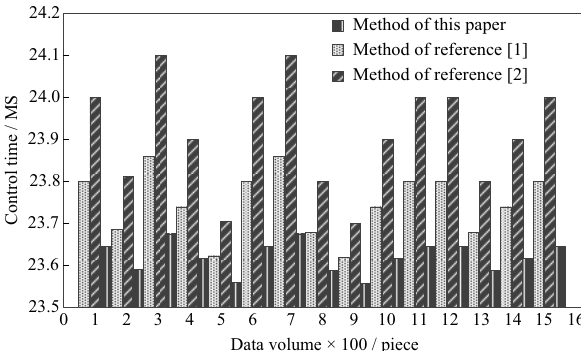
Figure 4: Comparison of control time overhead under three